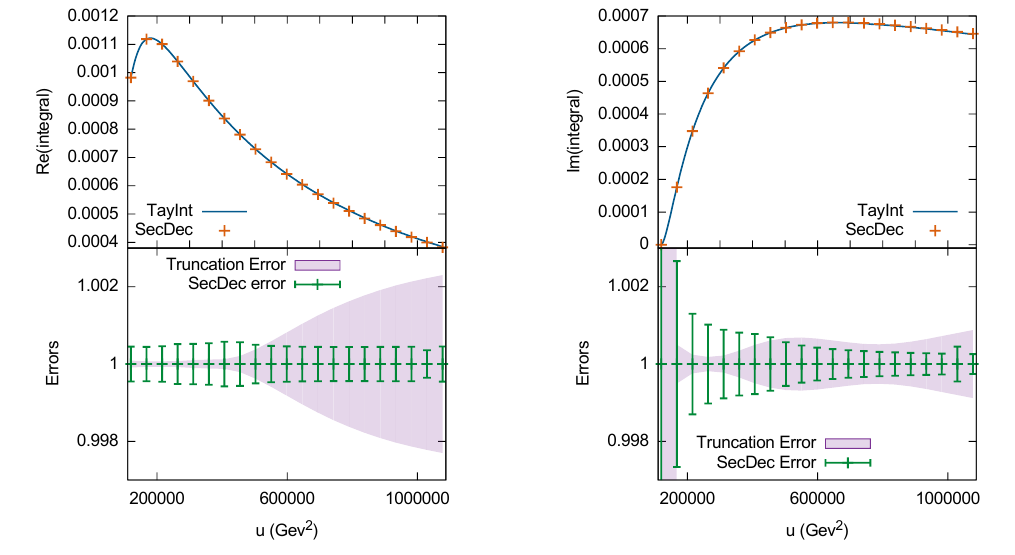
Figure 17 . The I10 Integral calculated at O ( (cid:15) 1 ) with a fourth-order series expansion. The scale u m 1 and m 1 = 173 GeV. The lower plots show the relative is over the 4 m 2 threshold, with m 2 = 1 p 1 2 uncertainties of the TayInt and numerical SecDec results, respectively.